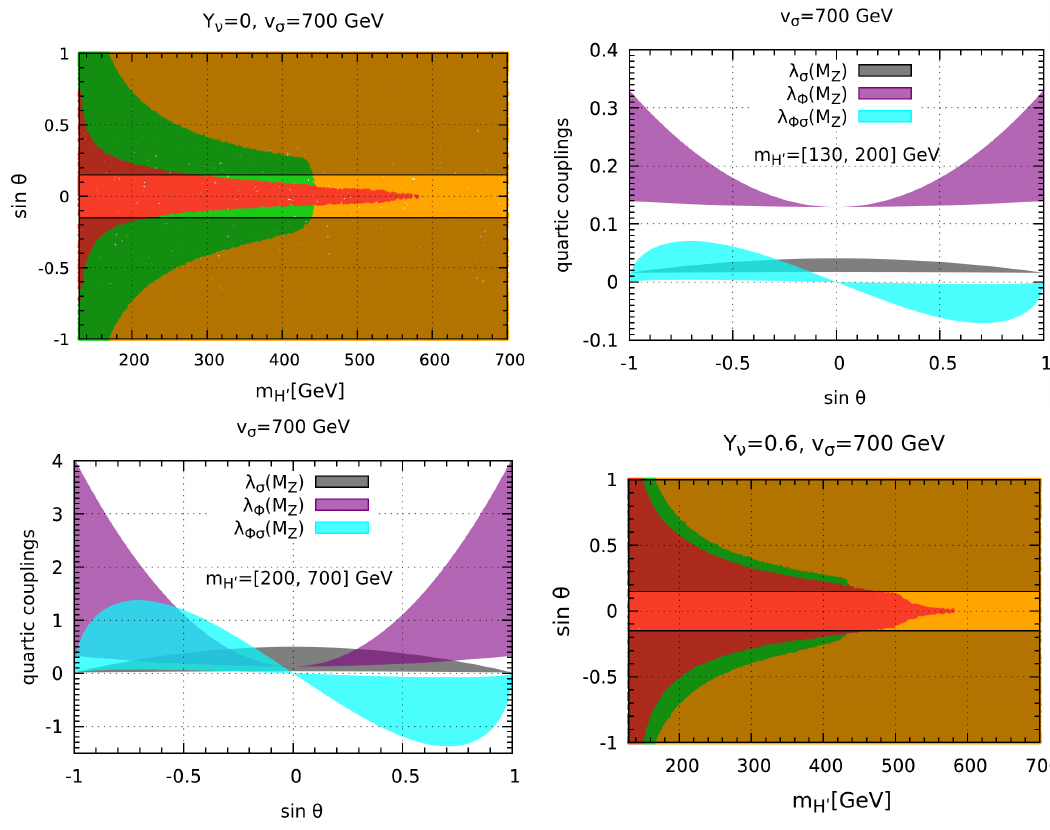
Figure 15 . Upper left panel: values of m H 0 and mixing angle θ leading to a stable vacuum with all couplings perturbative (green), non-perturbative couplings at some energy scale (brown), or an unstable potential (red). The region between the black lines is allowed by LEP-LHC constraints. We have fixed the heavy neutrino mass scale Λ = 10 TeV and v stability-perturbativity constraints up to M